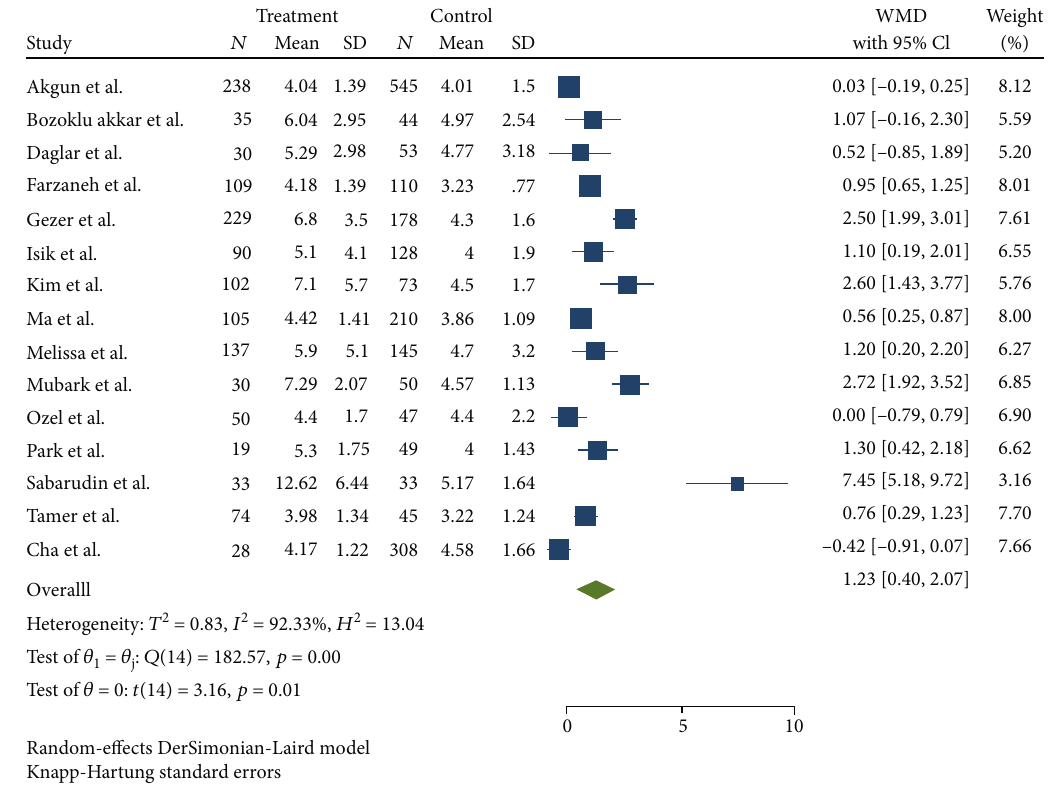
Figure 2: The forest plot of meta-analysis of the association between NLR and preterm delivery. Table 2: Outcomes of subgroup analysis for association between NLR and preterm